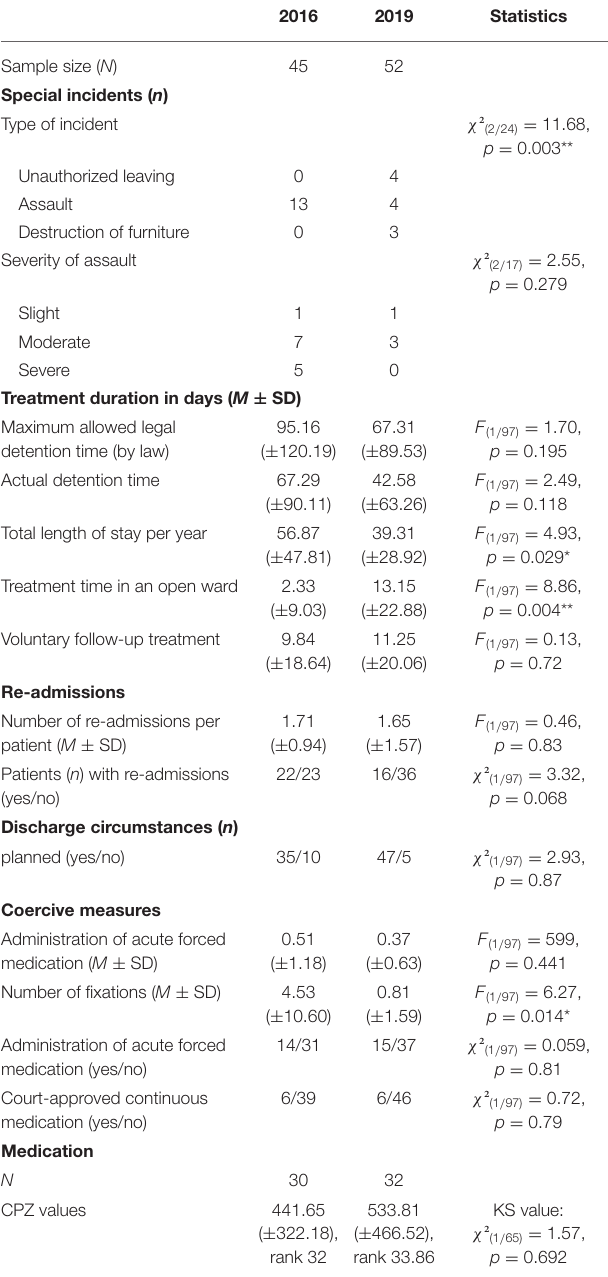
TABLE 2 | Number of special incidents, treatment duration, number of re-admissions, discharge circumstances, coercive measures, and chlorpromazine equivalents before and after the implementation of Soteria